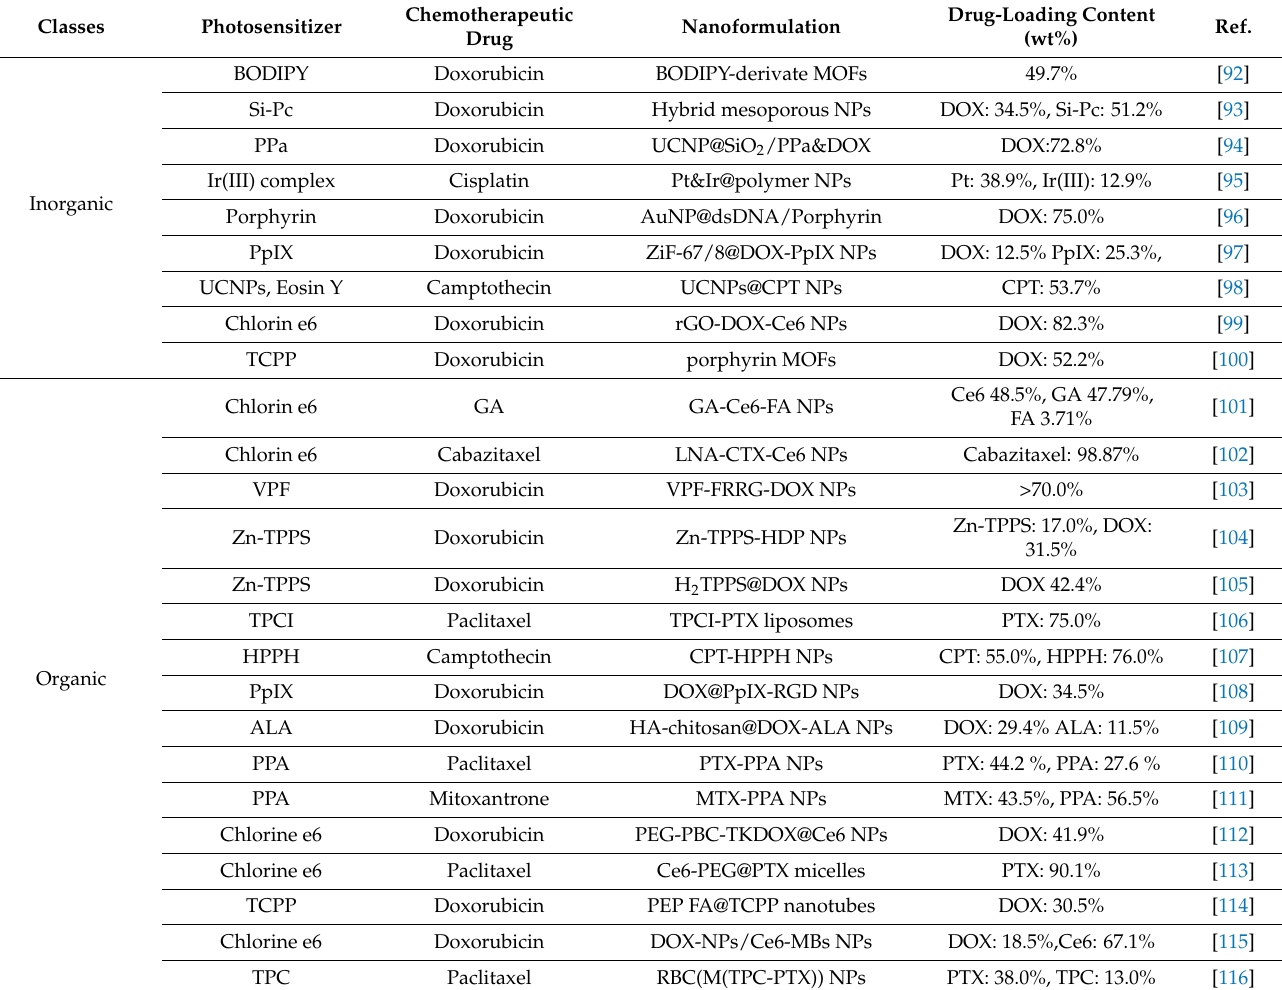
Table 2. A summary of different PSs as carriers for fabricating high drug-loading